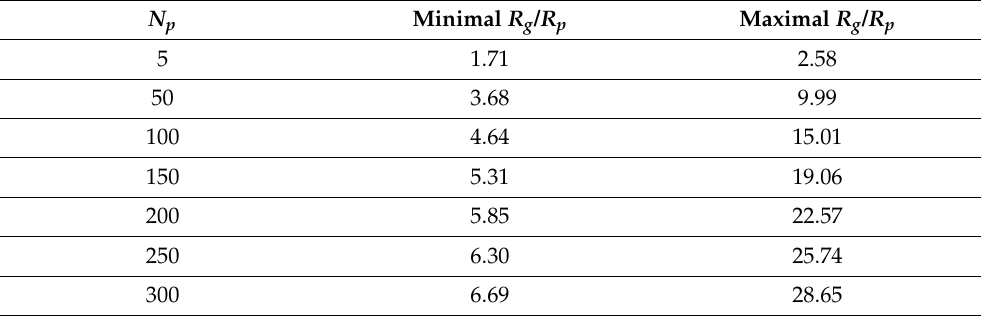
Table 3. Minimal R g / R p ( D f , PL = 3.0 and k PL = 1.0) and maximal R g / R p ( D f , PL = 1.7 and k PL = 1.0) of aggregates with different N p